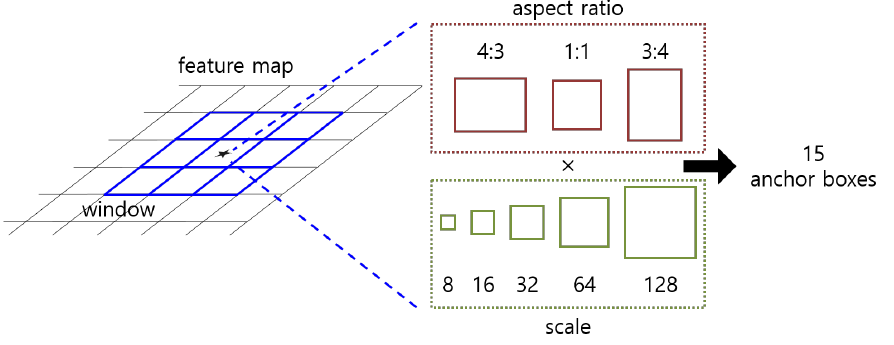
Figure 8. An illustration of the proposed anchor boxes for fragment